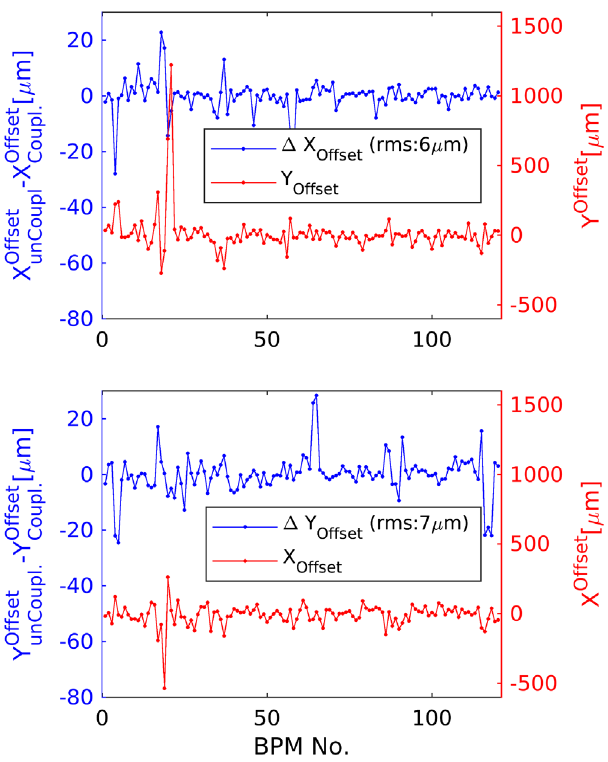
FIG. 15. Difference between the FBBA offsets at the 120 ALBA BPMs when including or excluding coupling effects (blue curves, left axis). In order to attempt to correlate this difference with cross-talk between the two planes, the offsets in the opposite plane are shown in the same plot (red curves, right